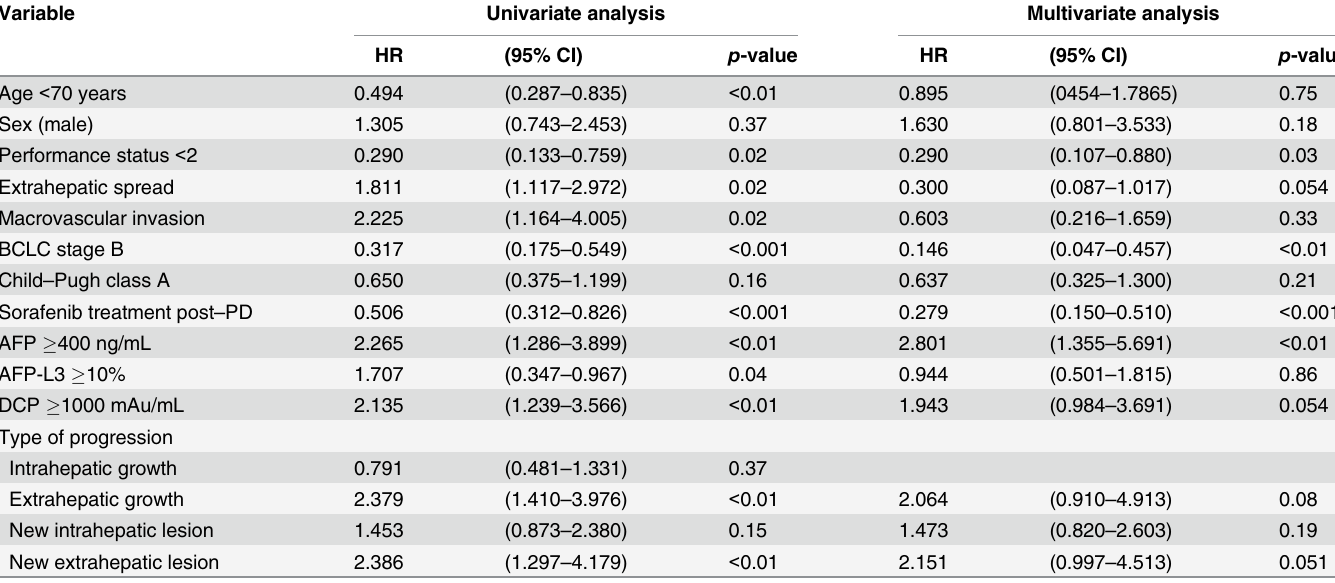
Table 2. Factors associated with survival in HCC patients with progressive